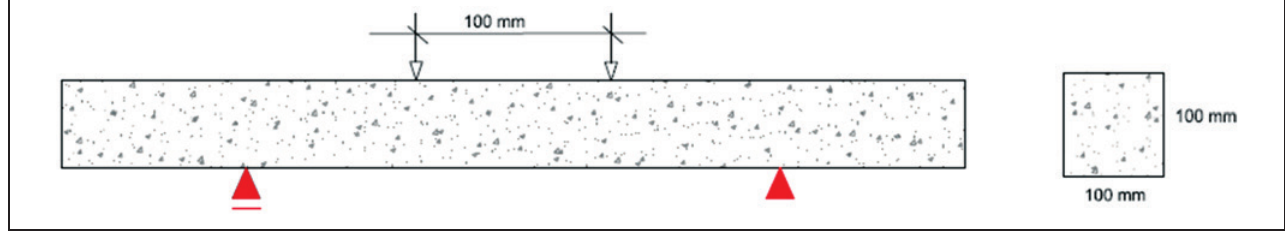
Figure 9 – Four-point flexure test used to identify the fiber variables